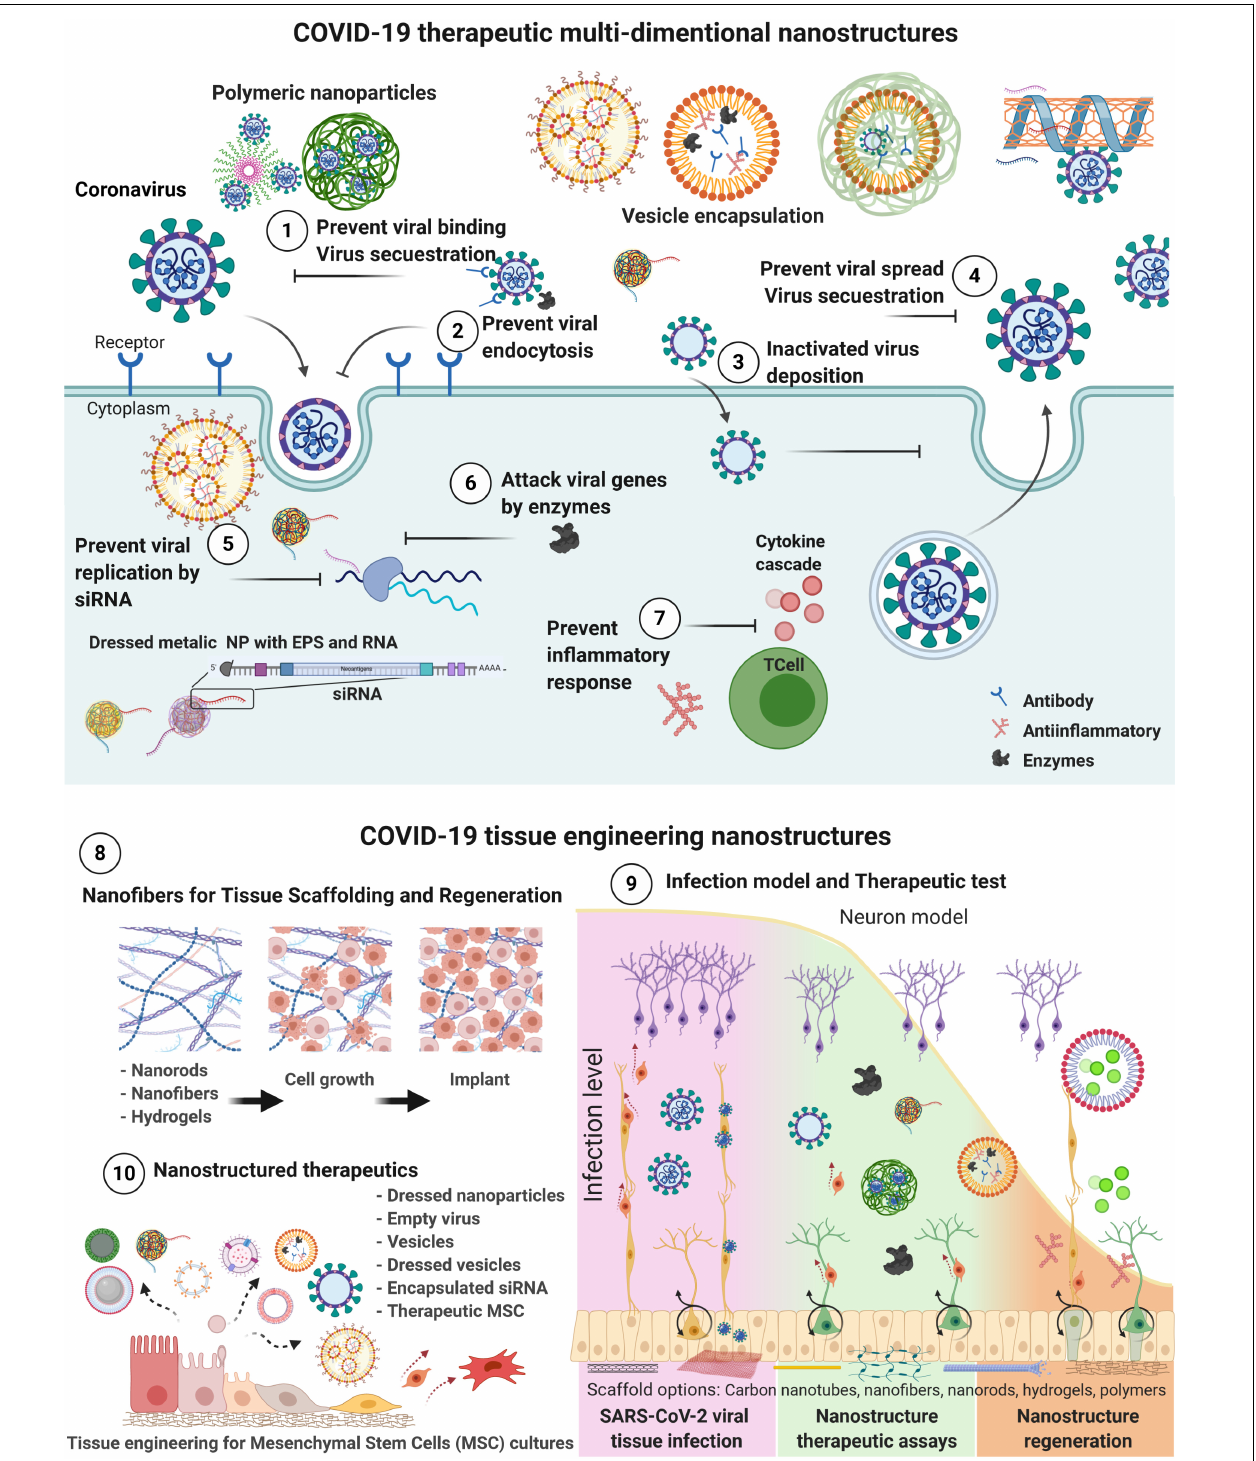
FIGURE 2 | Schematic representation of nanostructured-based technology focused to COVID-19 therapeutics. Therapeutic action mechanisms for COVID-19 treatments by drug delivery, dressed nanoparticles, vesicles carriers and MSC targeting different infection processes from (1 to 7). Tissue engineering nanostructured-based technology for (8) tissue regeneration, and implant preparation; (9) test infection, generate therapeutic assays, regeneration; and (10) Nano therapeutics production of vesicles, nanoparticles, and MSCs (Basu et al., 2020; Gordon et al., 2020; Gupta S. et al., 2020; Hassanzadeh, 2020; Hu et al.,